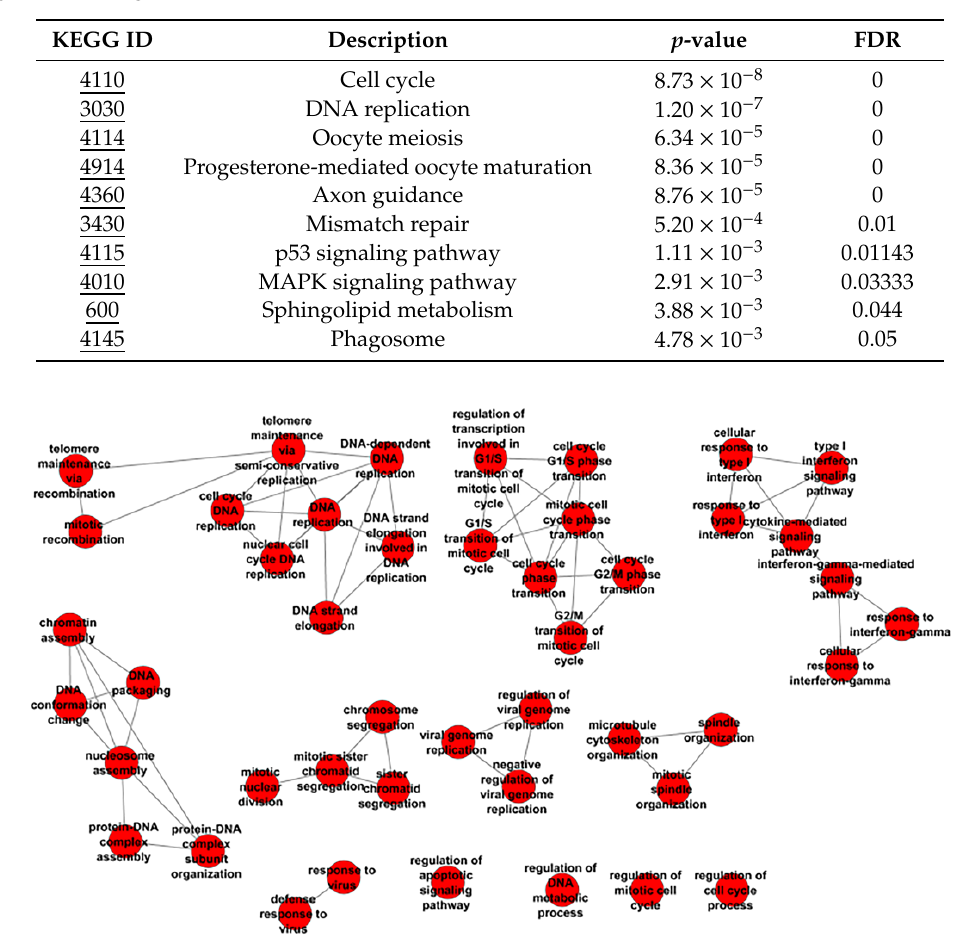
Figure 2. Enriched biological processes (BP) analysis of ER+ palbociclib-resistant breast cancer cells.